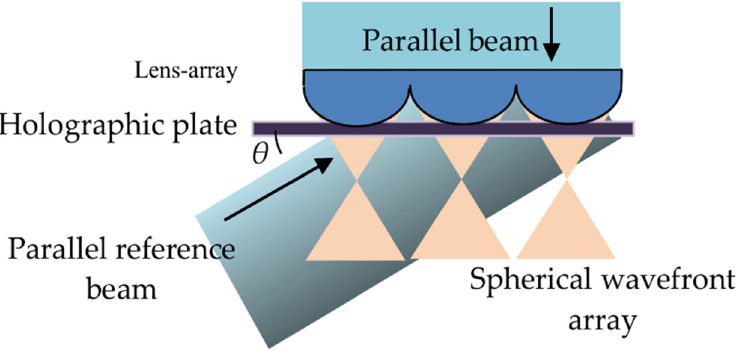
Figure 2. Fabrication principle of the lens-array HOE.